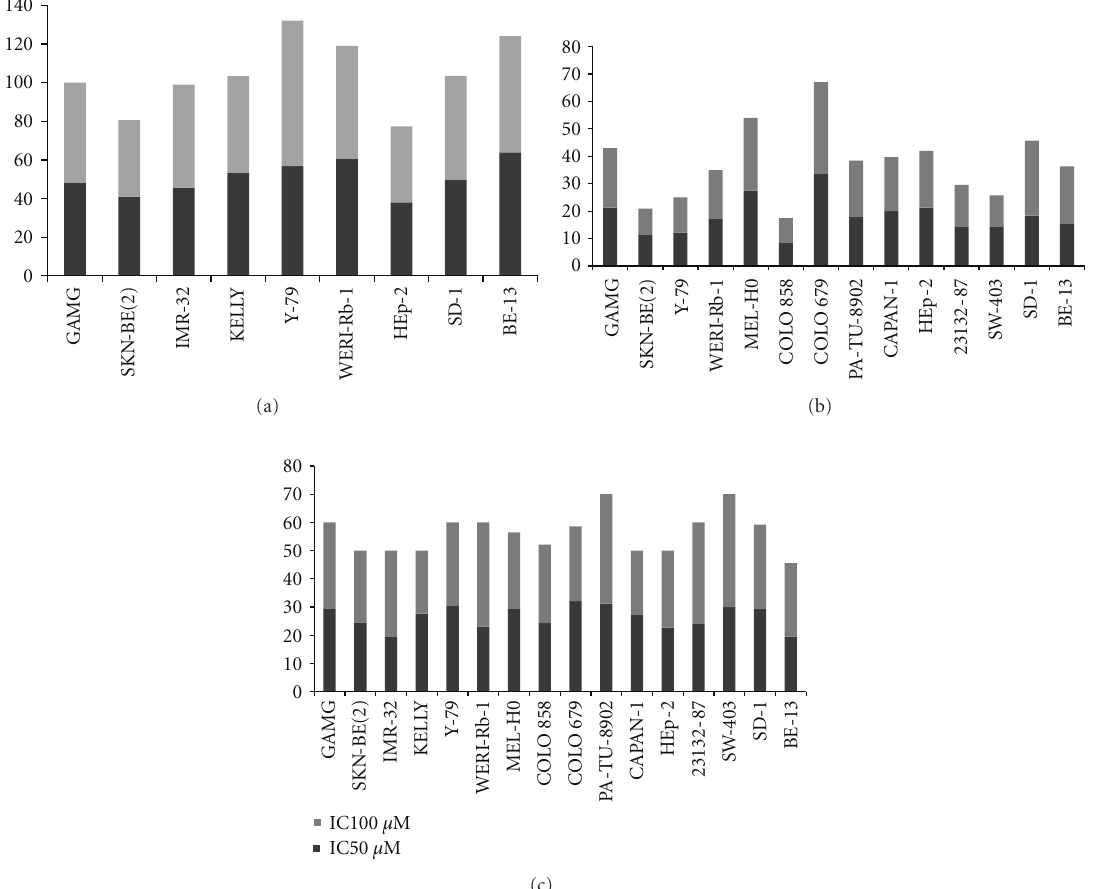
Figure 3: Cytotoxicity in human cell lines induced by NK-1 receptor antagonists. An up-to-date outline of our so far published results is shown for the antitumor e ff ect of NK-1 receptor antagonists (a) L-732,138, (b) L-733,060, and (c) aprepitant in a variety of human cell lines of di ff erent tissues including glioma, neuroblastoma, retinoblastoma, melanoma, carcinoma of pancreas, larynx, stomach, and colon. Concentrations of the antagonists are shown in μ Molar for each cell line corresponding to 50 and 100 percent inhibition by cytotoxicity assay.